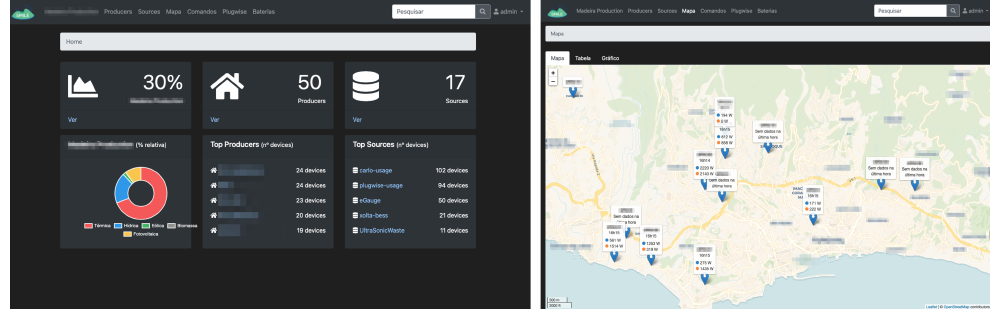
Figure 5. Admin screen of the ESB. Left : Main screen of the administration interface; Right : Map view showing a sub sample of monitored